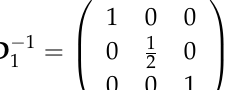
4, displays the time evolution of the error with initial